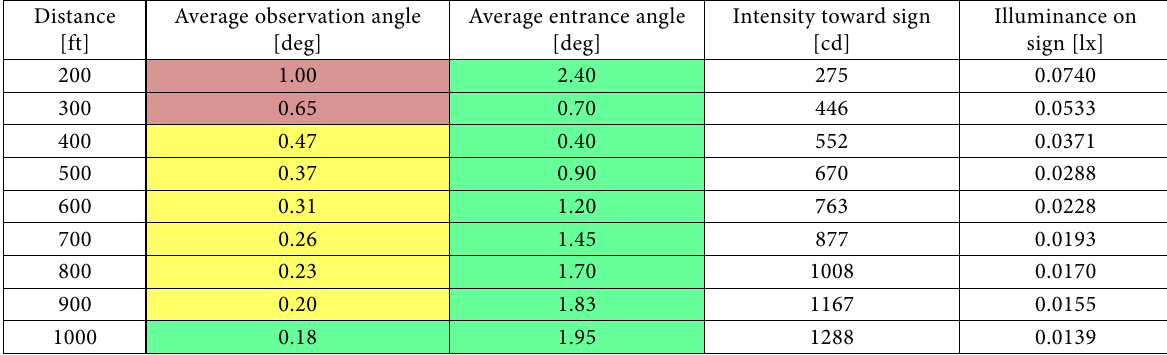
Table 3. Geometric and illumination conditions from low-beam headlamp illumination for overhead guide signs viewed from difference distances